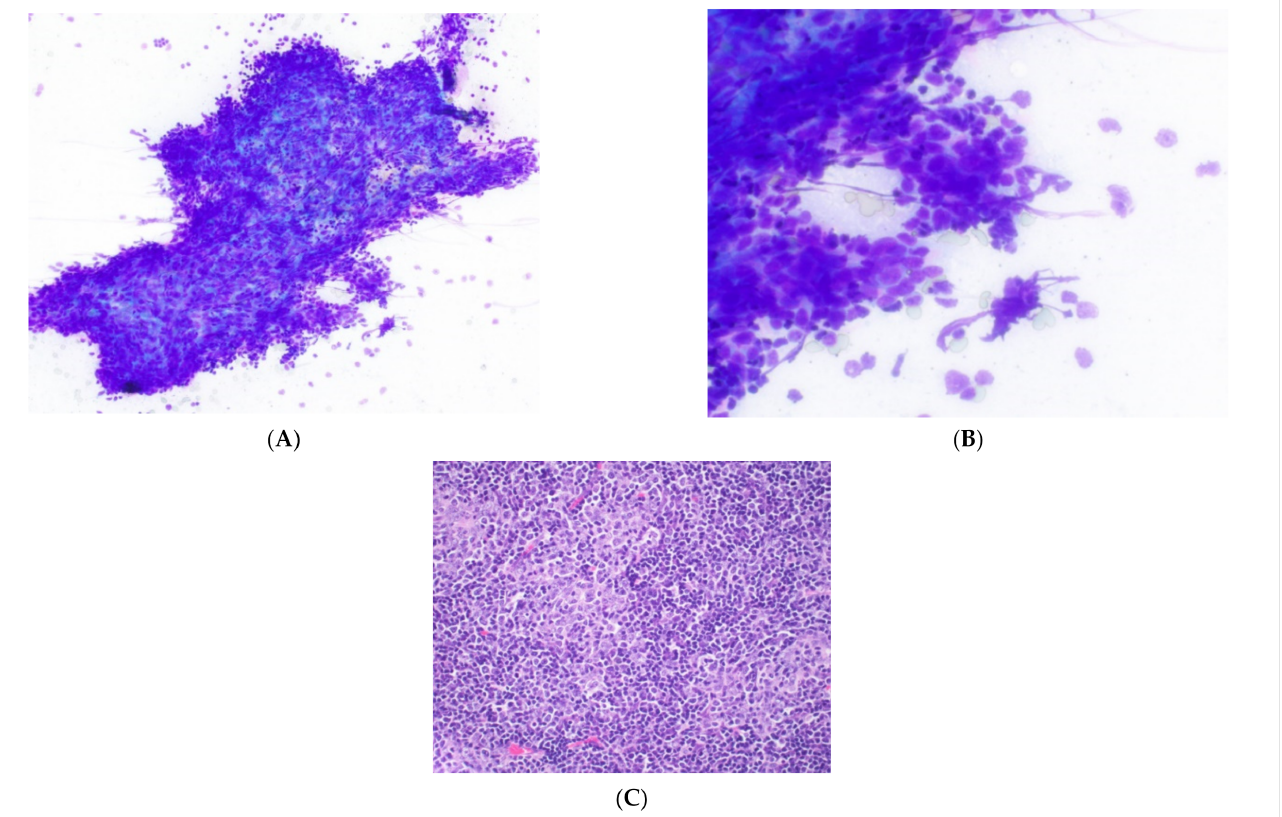
Figure 5. Type B thymoma. ( A ) Low-power and ( B ) high-power views of clustered round to ovoid epithelial cells of type B thymoma in close association with lymphocytes. Romanowsky stain, 20 × & 60 × objectives. ( C ) Surgical resection of type B2 thymoma showing clustered round epithelial cells in association with